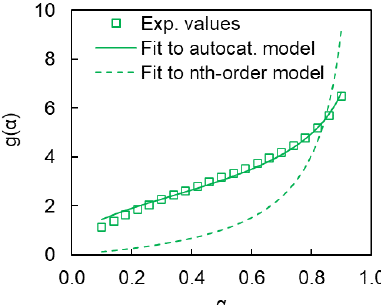
Figure 13. Fitting of the n th -order and autocatalytic models to the experimental g ( α ) dependence for polymerization of confined cyanate ester (SCC of type A).